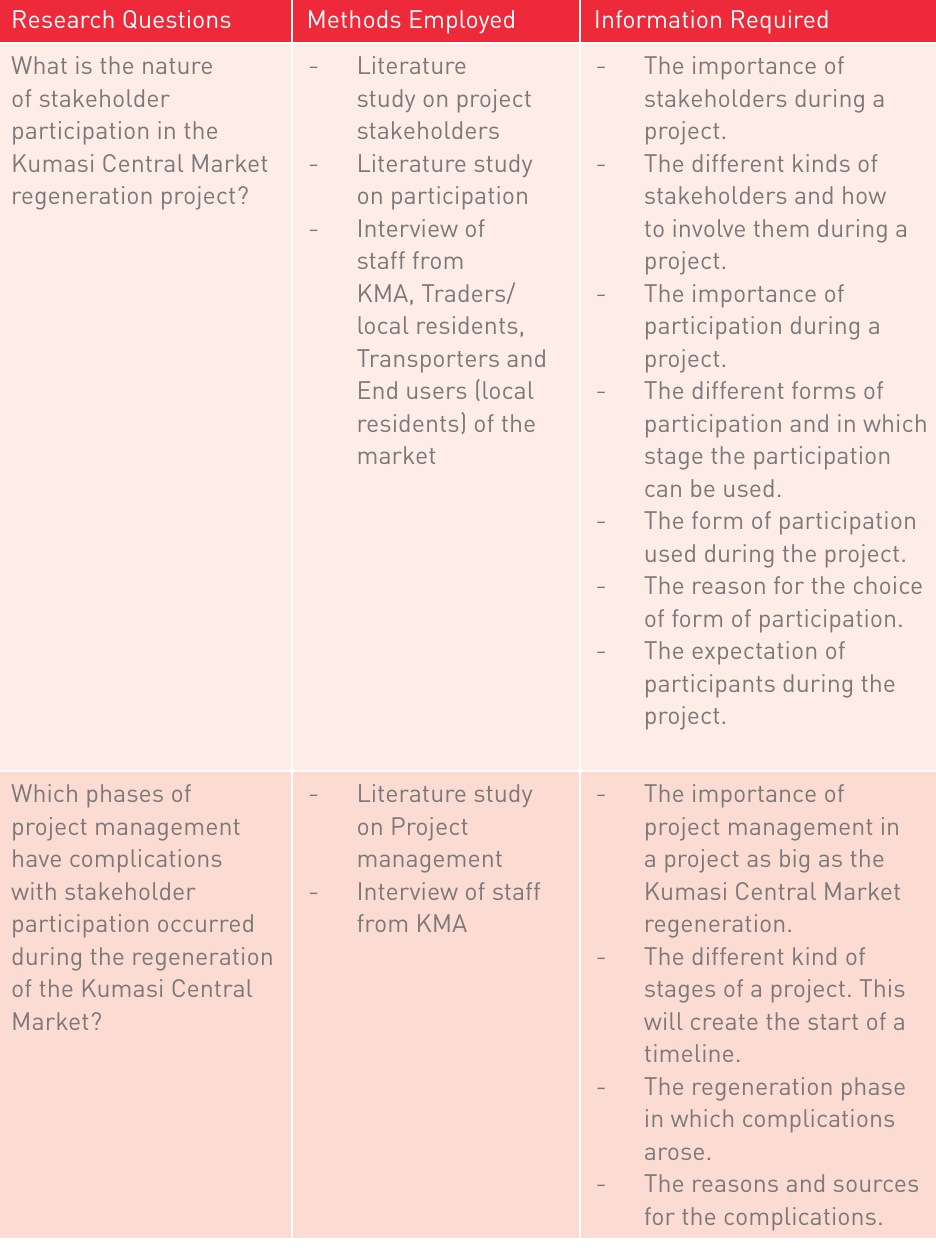
Summary sub-questions and